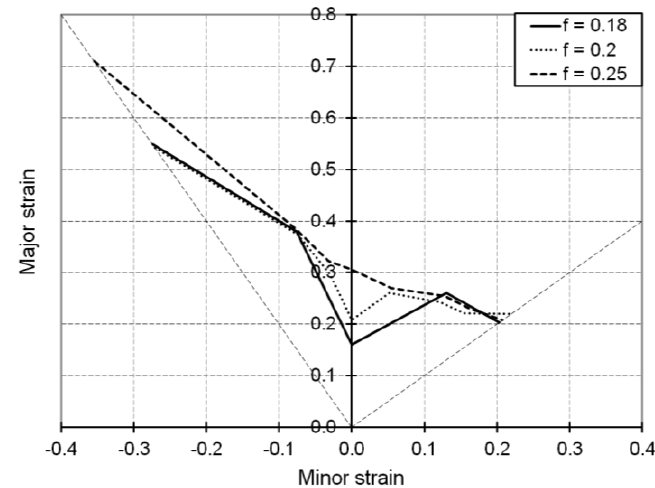
Figure 8. Simulated FLDs associated with linear loading paths for the IF – Ti single-phase steel as obtained with the Bifurcation–EPSC model: Effect of the volume fraction f of dense dislocation sheets.